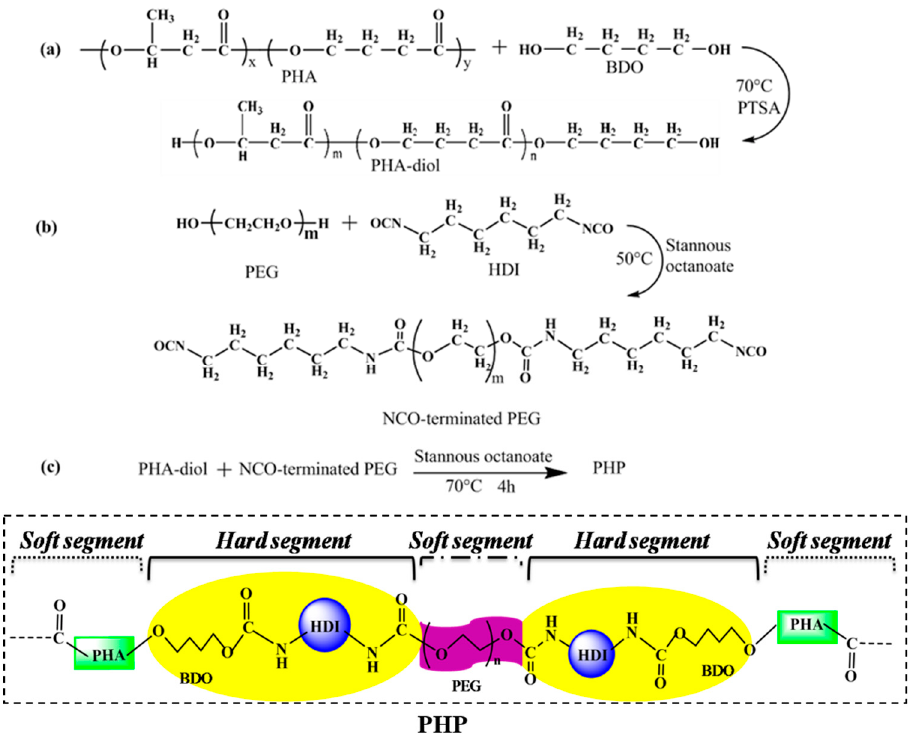
Figure 1. Illustration for the synthetic process of ( a ) PHA-diol, ( b ) the prepolymer(NCO-terminated PEG), ( c ) polyhydroxyalkanoate (PHA)-based polyurethane (PHP) and their structure.